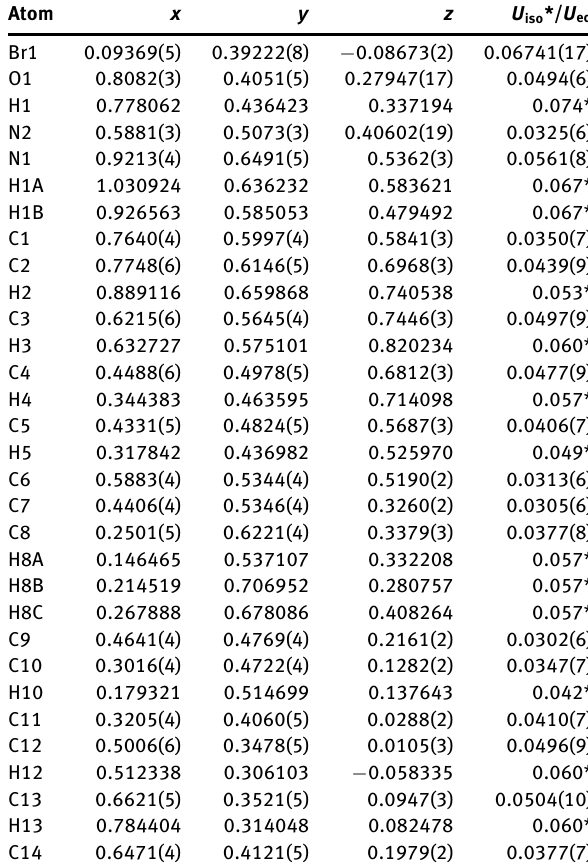
Table 2: Fractional atomic coordinates and isotropic or equivalent isotropic displacement parameters (Å 2